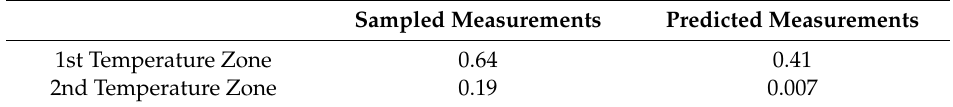
Table 1. The comparison between the sampled and predicted measurements for both temperature